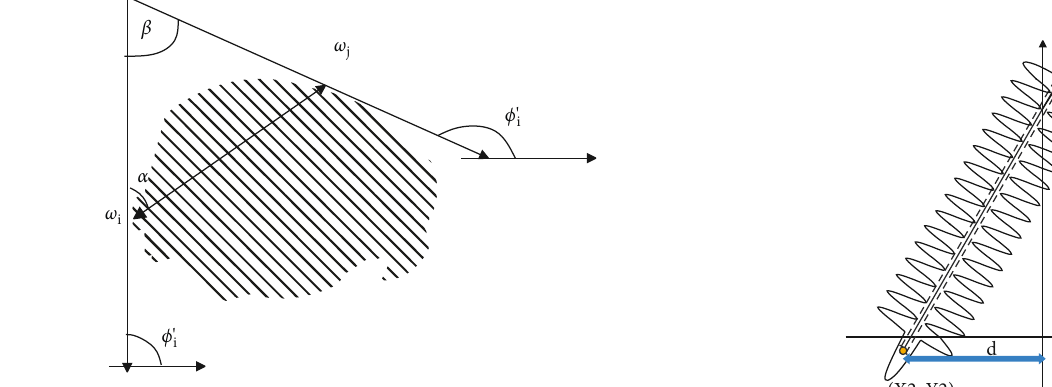
Figure 2: Invariant generalised Hough transform displacement vector.